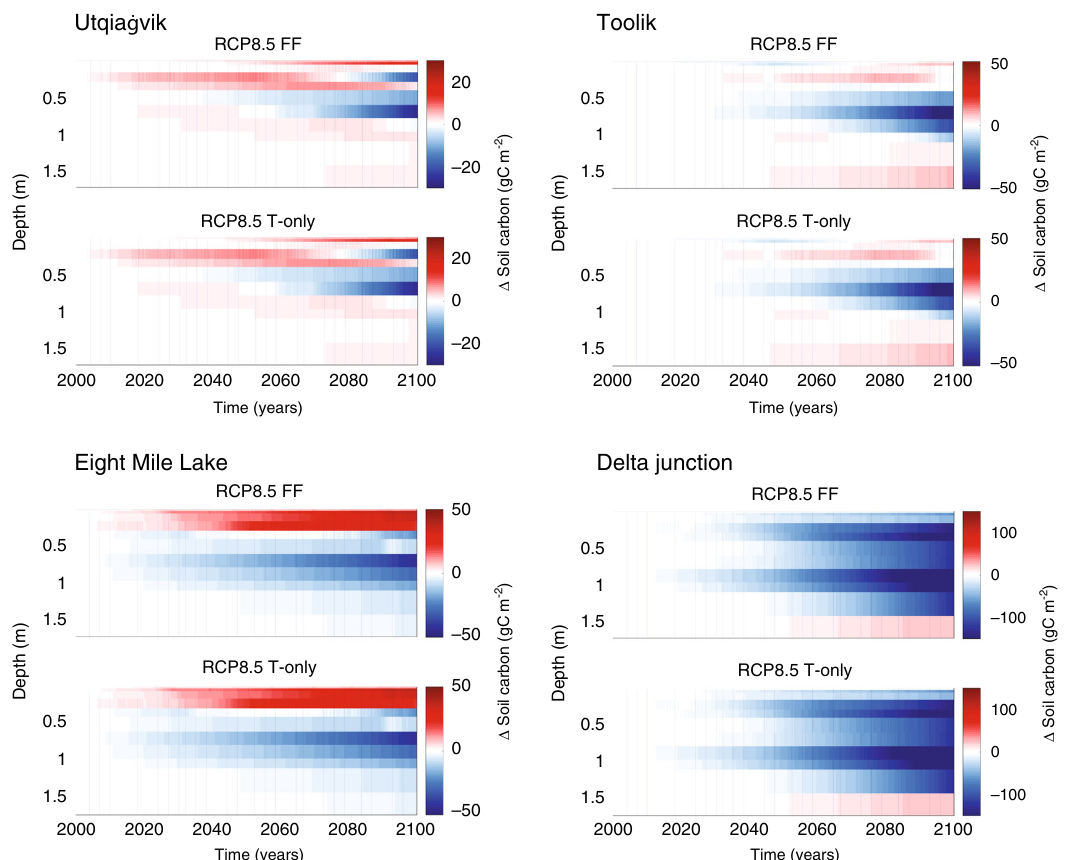
Fig. 6 Soil carbon changes over time and depth. The panels show the depth-dependent changes in soil carbon (gC m − 2 ) over time at each site. Red represents inputs of SOC, while blue indicates depths where soil organic carbon is lost. Note, the color-bar axes denoting changes in soil carbon differs from site to